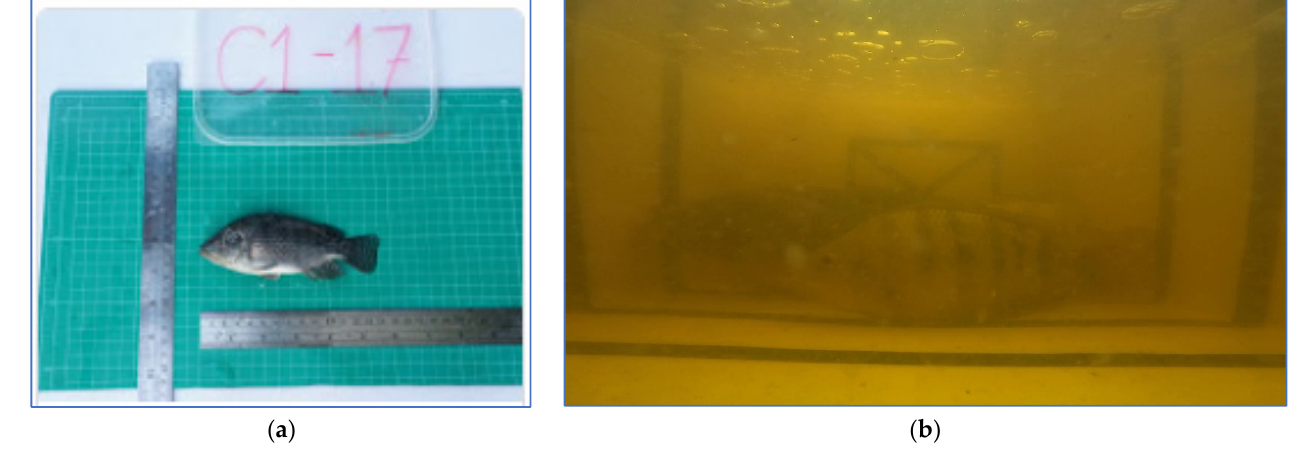
Figure 3. Example of Tilapia images from ( a ) studio; ( b ) biofloc